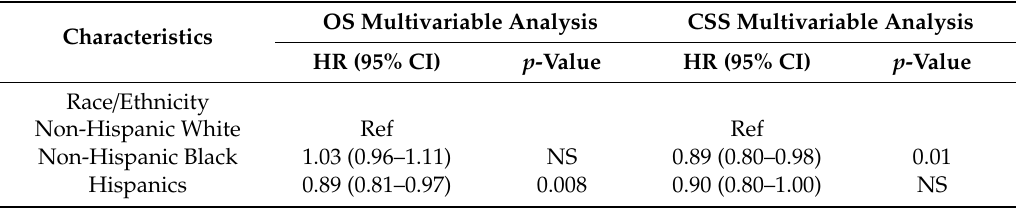
Table 2. Multivariable Cox regression analysis for overall survival and cause-specific